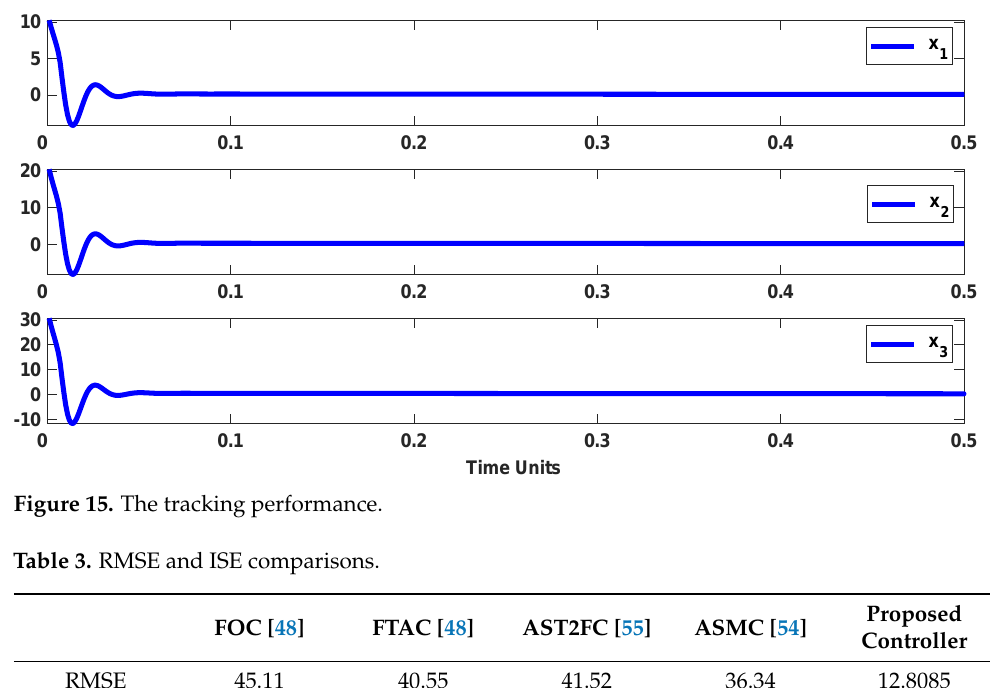
Figure 15. From Figure 15, we see that the suggested controller had the desired accuracy in spite of the unmown dynamics.